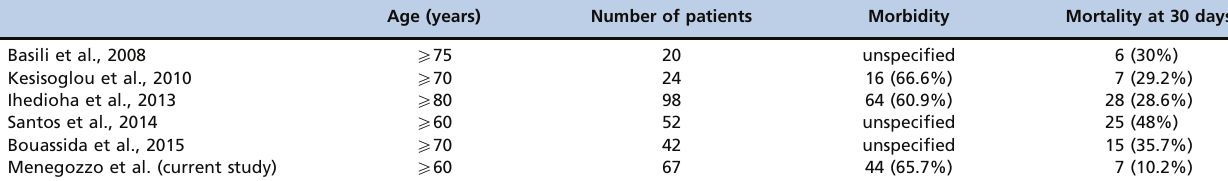
Table 4 - Morbidity and mortality of elderly patients undergoing emergency surgical